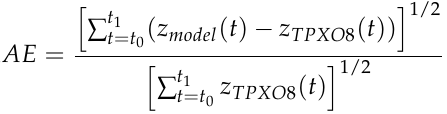
Figure 3. Detail of unstructured grid used in current model showing increased horizontal resolution and the use of inland hydrodynamic cells in Abu Dhabi. Black lines show the coastline, and red lines indicate breakwaters already in existence as of 2022.